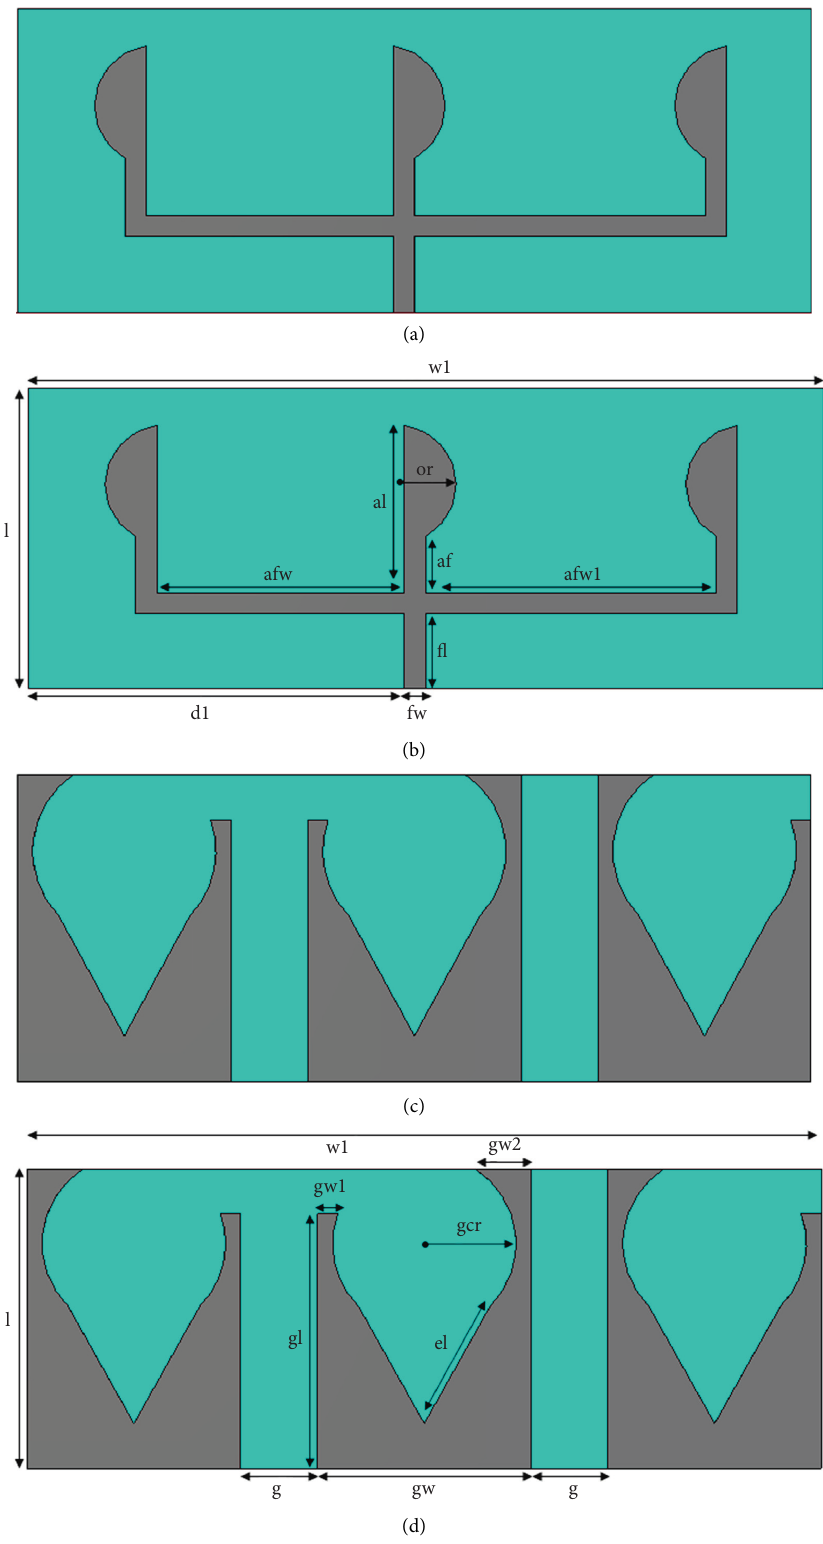
Figure 2: Array three (a, b) top view and (c, d) bottom view.(a) View from the top.(b) Top view (schematic diagram).(c) Back view.(d) Back view (schematic